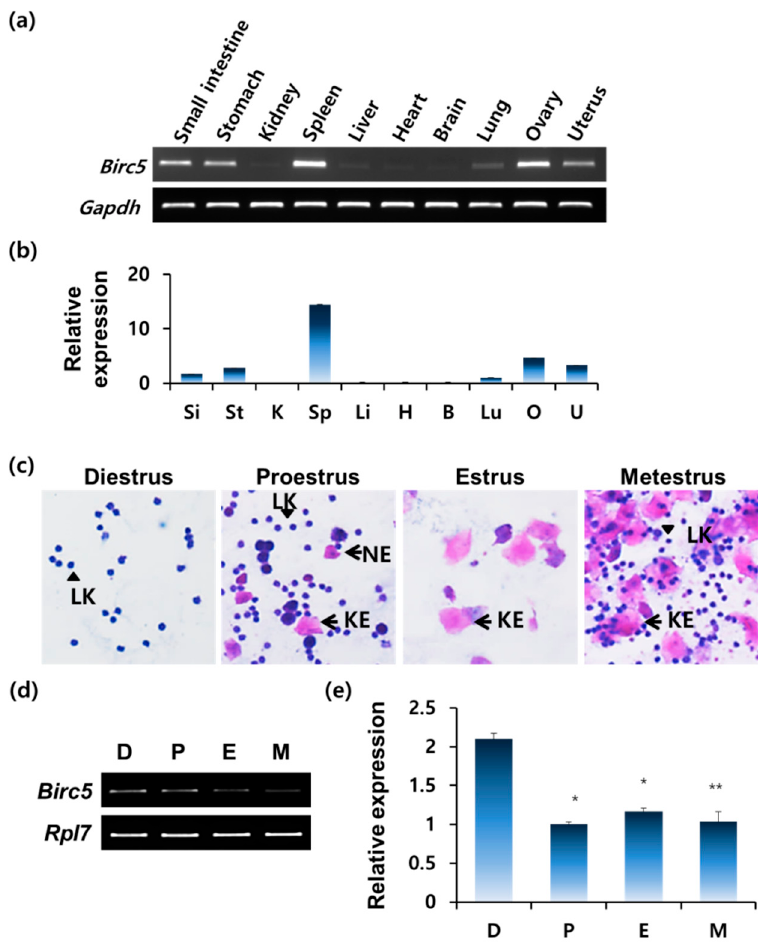
Figure 1. Baculoviral inhibitor of apoptosis repeat-containing 5 ( Birc5 ) expression in mouse tissues. ( a ) RT-PCR analysis of Birc5 mRNA in the small intestine, stomach, kidney, spleen, liver, heart, brain, lung, ovary, and uterus using total RNA extracted from a 6-week-old female mouse ( n = 4). Gapdh transcript was used as an internal control. ( b ) Quantitation of the relative mRNA expression of Birc5 in mouse tissues: Si, small intestine; St, stomach; K, kidney; Sp, spleen; Li, liver; H, heart; B, brain; Lu, lung; O, ovary; U, uterus. The criterion of relative expression change was based on the value at small intestine. ( c ) Vaginal smear assay to classify the estrous cycle: NE, nucleated epithelial cell; LK, leukocyte; KE, keratinized epithelial cell. ( d ) RT-PCR results of Birc5 expression in mouse uterus at di ff erent estrous stages ( n = 4) confirmed by vaginal smear assay. D, diestrus; P, proestrus; E, estrus; M, metestrus. ( e ) Quantitation of the relative mRNA expression of Birc5 in mouse uterus. The criterion of relative expression change was based on the value at metestrus stage of the estrous cycle. Expression levels were normalized against Rpl7 mRNA. D, diestrus; P, proestrus; E, estrus; M, metestrus. * p -value < 0.05, ** p -value < 0.01.